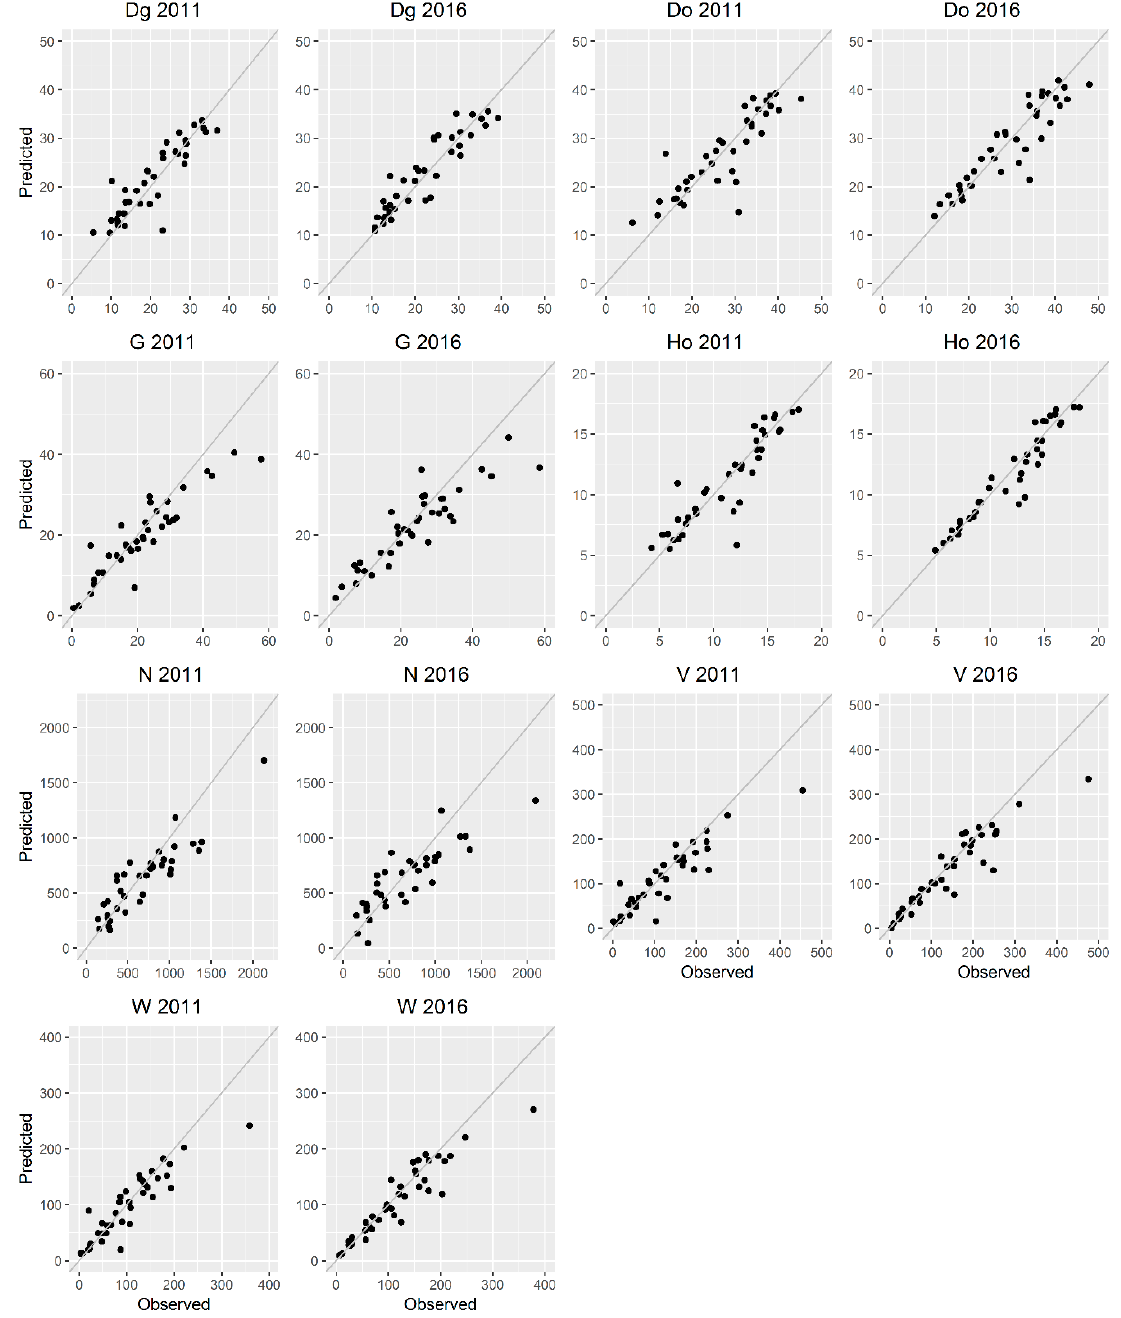
Figure A1. Scatterplot of predicted vs. observed values of the forest stand variables using the best-selected SVM with radial kernel 2011 models and 2016 extrapolated models. Dg and Do are expressed in cm; G is expressed in m 2 ha − 1 ; H is expressed in m; N is expressed in stems ha − 1 ; V is expressed in m 3 ha − 1 ; W is expressed in tons ha − 1 .